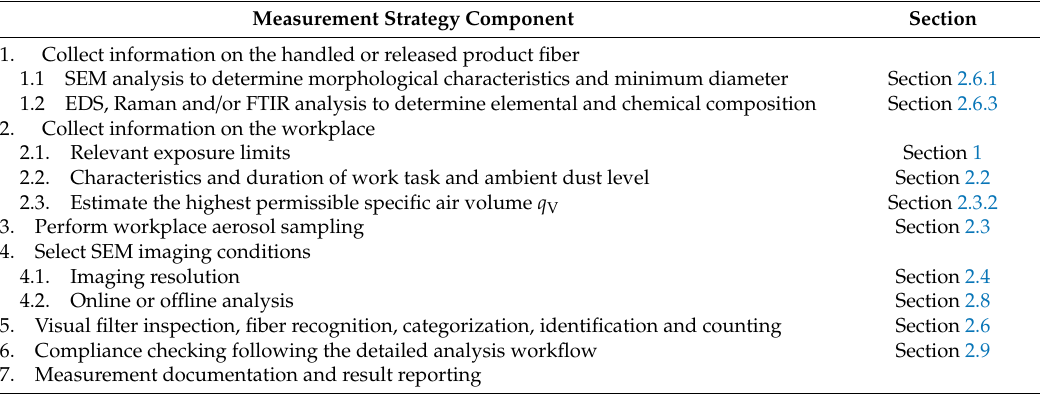
Table 2. General workflow of the measurement